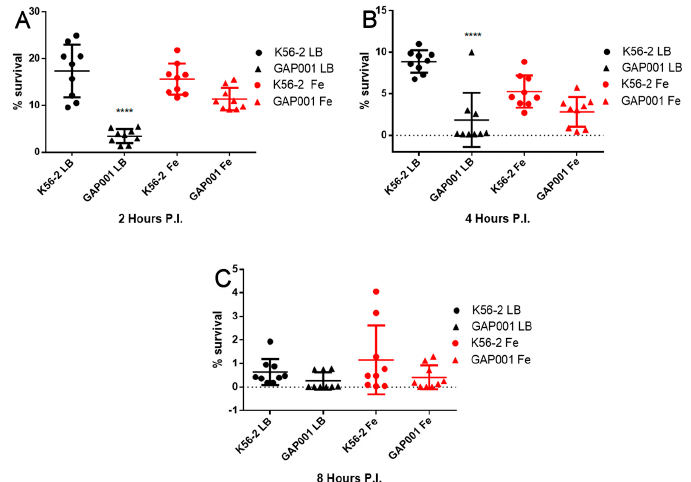
Figure 2. GAP001 intracellular uptake and survival in RAW264.7 cells. Cells were infected with B. cenocepacia or GAP001 grown either in LB alone or LB with 200 µ M FeSO 4 , at a multiplicity of infection (MOI) of 10. At 2 ( A ), 4 ( B ) and 8 ( C ) h, cells were lysed and bacterial uptake and survival was determined by dilution plating. Individual data points are shown as well as mean ± S.D. Levels of significance ( p <